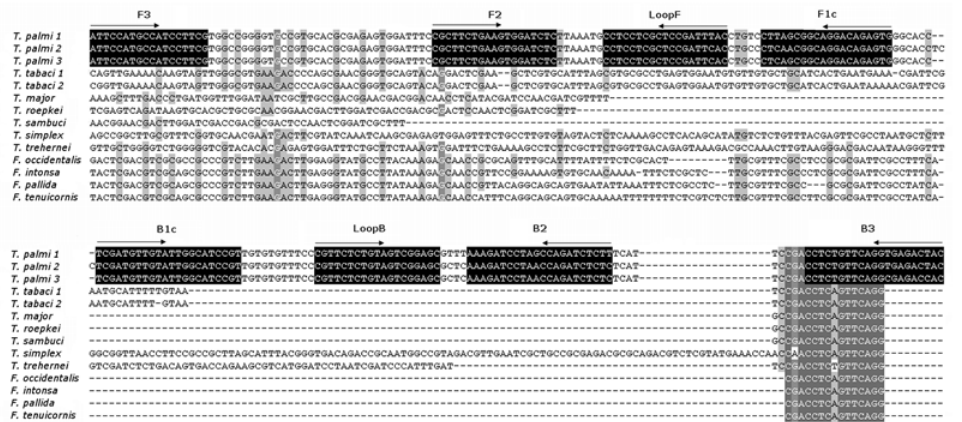
Fig 1. Multiple sequence alignment of the rDNA region of analyzed thrips species. The loop-mediated isothermal amplification (LAMP) primer sequences are indicated (black background). The alignment was generated using the GeneDoc software [23].